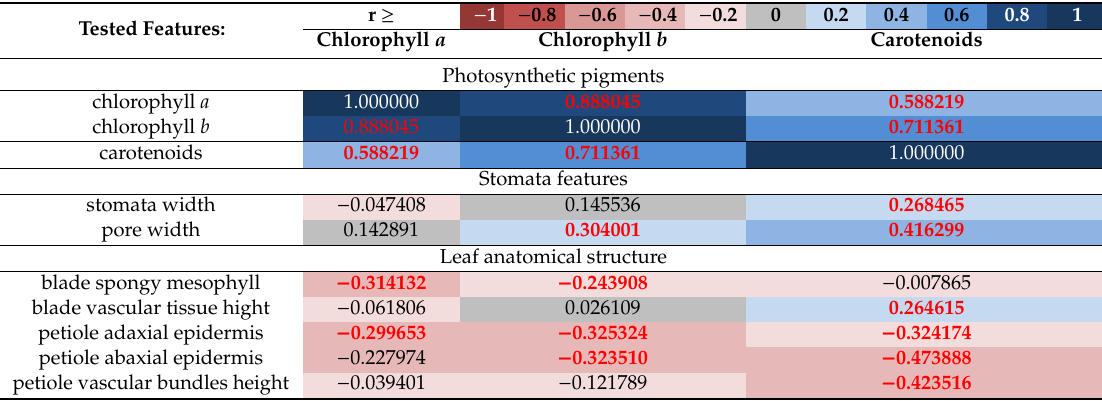
Figure 5. Characteristics of gerbera leaf anatomy: ( a ) blade and ( b ) petiole structure after 6 weeks of in vitro cultivation of shoots depending on BA concentration in the medium—1, 2.5 or 5 µM; tissue thickness in µm; mean values are presented with standard deviation bars; columns followed by the same letter are not significantly different according to Duncan’s multiple range test at p ≤ 0.05.